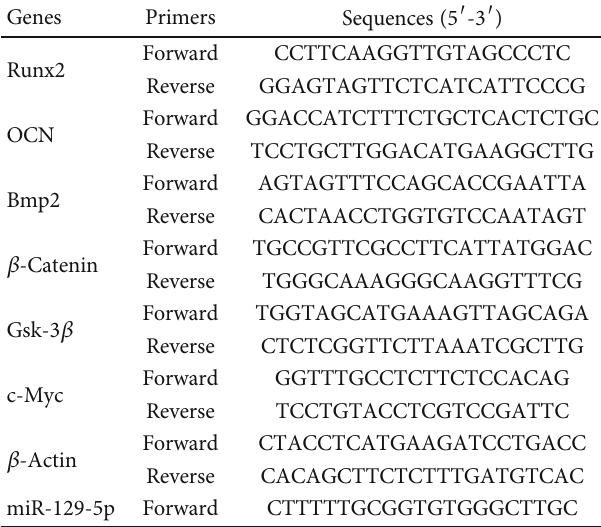
Table 1: RNA primer sequence. Genes Primers Sequences (5 ′ -3 ′